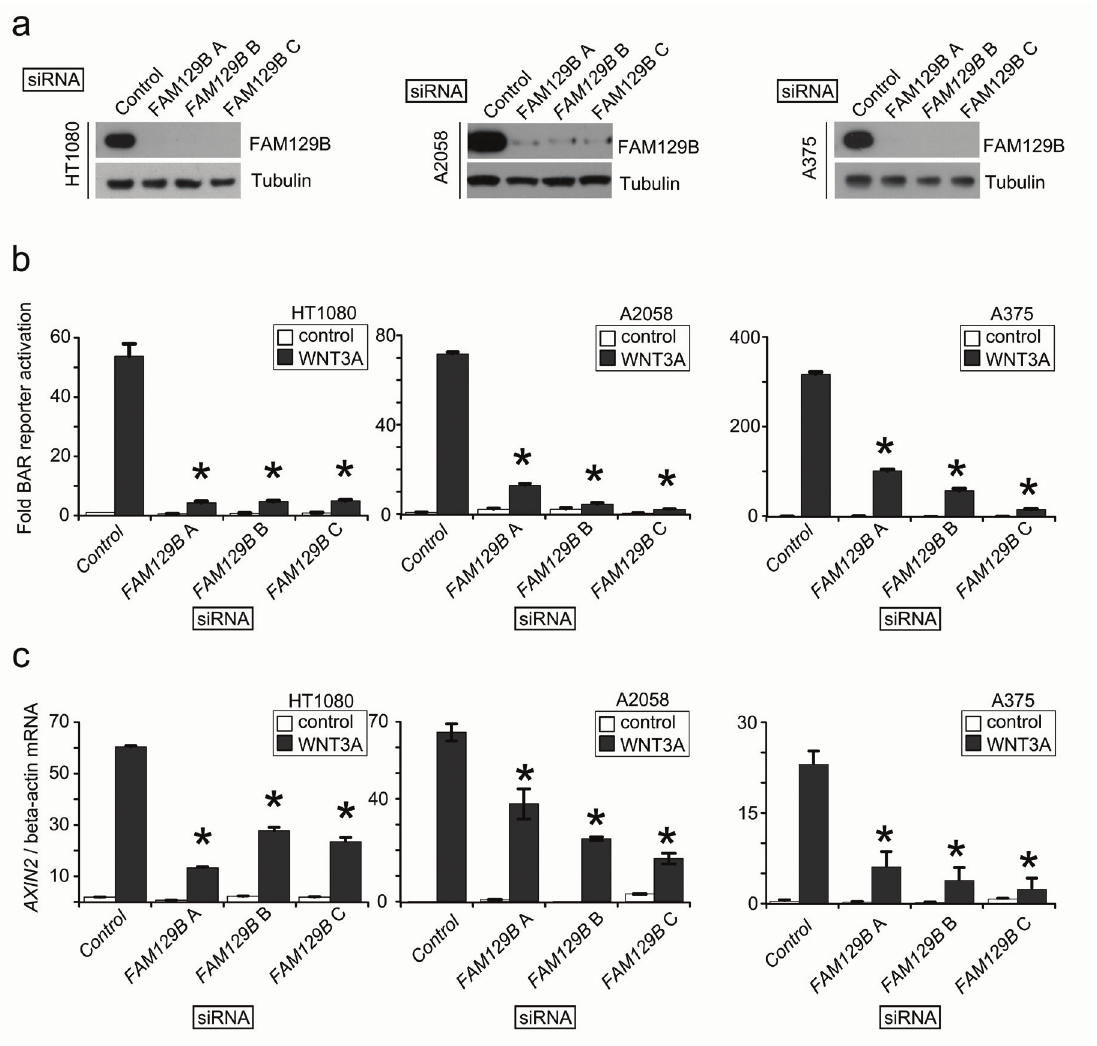
Figure 2. FAM129B positively regulates Wnt/ β -catenin signal transduction in a panel of three cell lines. ( a ) Immunoblots show three independent siRNAs reduce steady-state levels of endogenous FAM129B following 72 hr treatment with 20 nM siRNA. The beta-tubulin immunoblot serves as a control. Three independent siRNAs targeting FAM129B inhibit FAM129B expression in HT1080 (left), A2058 (middle), and A375 cells (right). ( b ) FAM129B siRNA inhibit WNT3A-dependent luciferase reporter activity (BAR reporter) normalized to constitutively expressed Renilla luciferase in HT1080 (left), A2058 (middle), and A375 cells (right). ( c ) FAM129B siRNA inhibit Wnt-dependent AXIN2 expression in HT1080 (left), A2058 (middle), and A375 cells (right) relative to beta-actin mRNA expression by qPCR. Columns and error bars represent mean and SEM, respectively. Data are representative of at least three separate biological replicates. *p<0.05 by unpaired, two-tailed